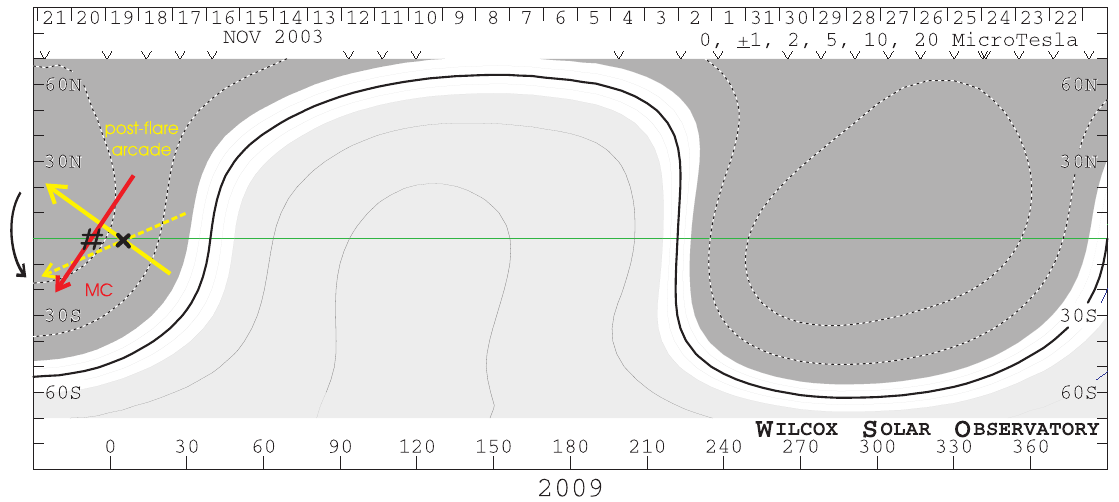
Fig. 13. WSO coronal magnetic field extrapolation at 2.5R (cid:12) of Carrington rotation 2009 showing the source surface field and the heliospheric current sheet (HCS). The position of the solar source and the associated MC that arrived at 20 Nov at the Earth are marked as x and # , respectively. The orientation of the axial magnetic field of the post-flare arcade and the axial magnetic field of the MC with respect to the ecliptic are given as yellow and red arrows,